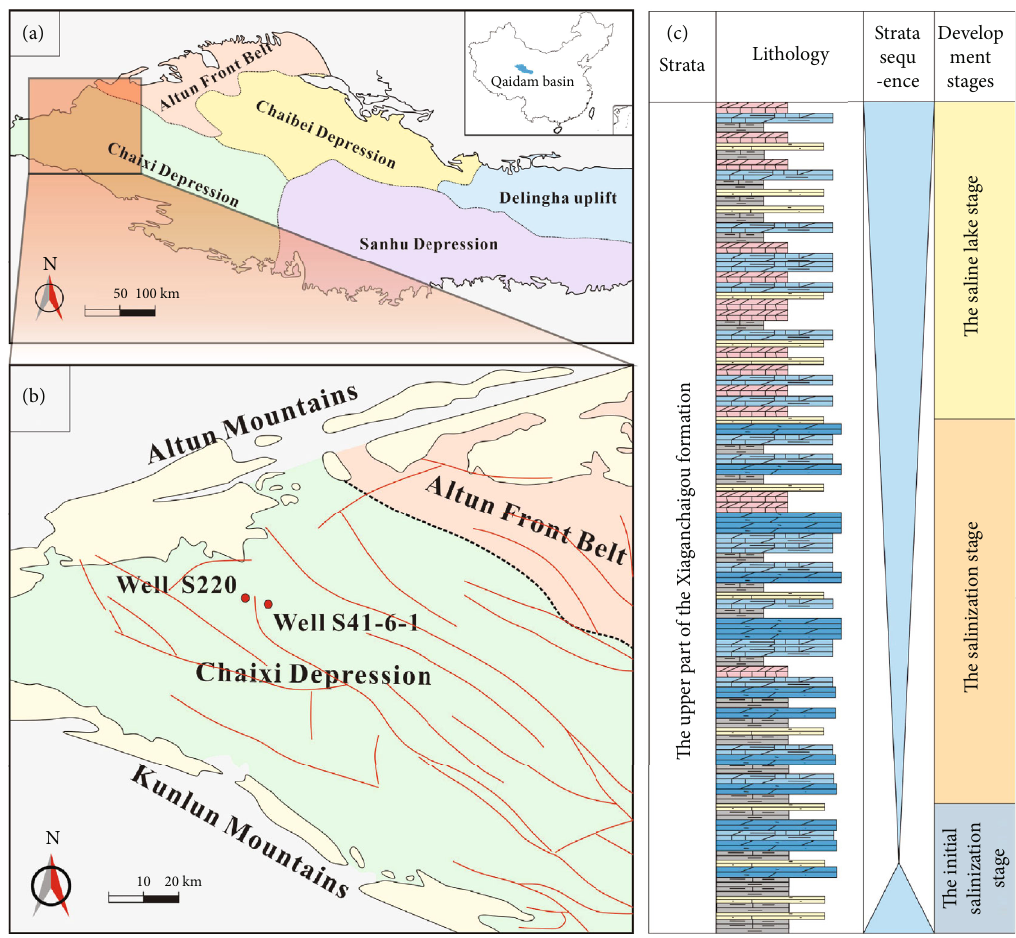
Figure 1: (a) Map showing the tectonic subdivisions of the Qaidam Basin in the northwestern China and the location of research area (indicated by the box). (b) Map showing the location and Chaixi Depression and targeted boreholes. (c) Vertical pro fi le of the Upper member of Palaeogene Xiaganchaigou Formation showing lithology and sequences. Table 1: Details of tight reservoir samples collected from the E 32 member of Xiaganchaigou Formation, Qaidam